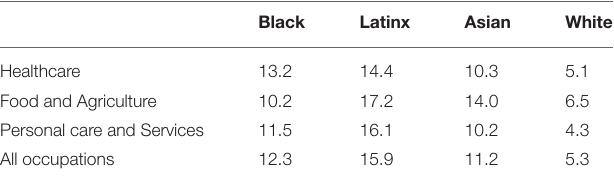
TABLE 4 | Workers ages 50–64, Percent living in 3-generation households by occupation, US 2018.